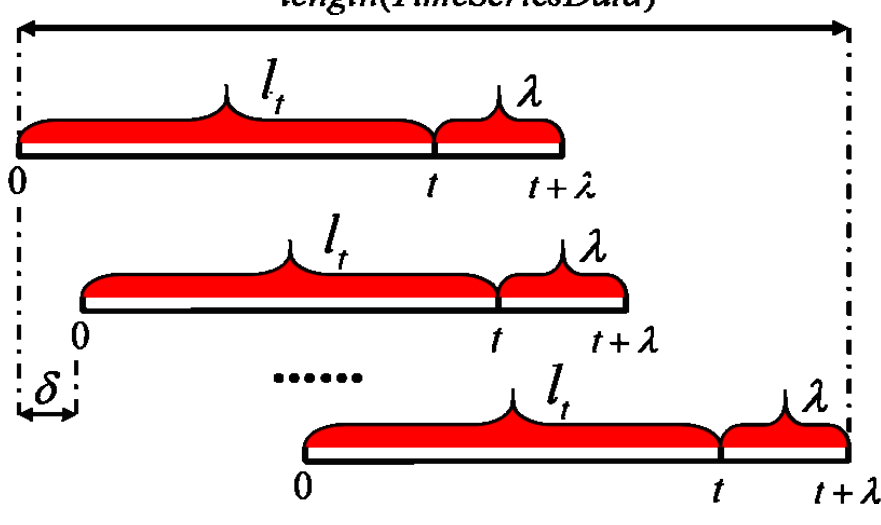
Figure 4. Data slicing in the data pre-processing module.